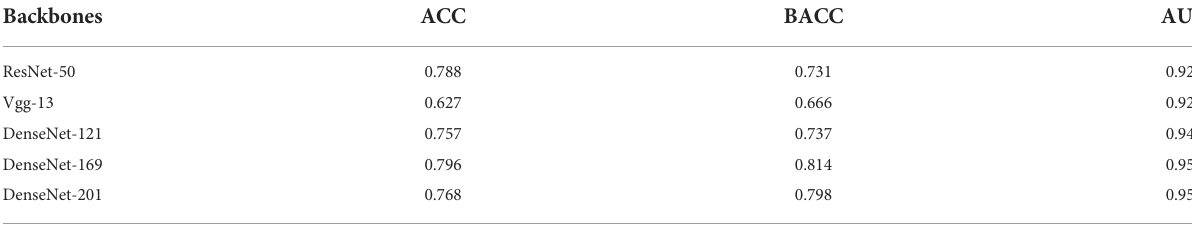
TABLE 4 Comparing the performance of different CNNs models incorporating MD-Net modules on the PAD-UFES-20 dataset.